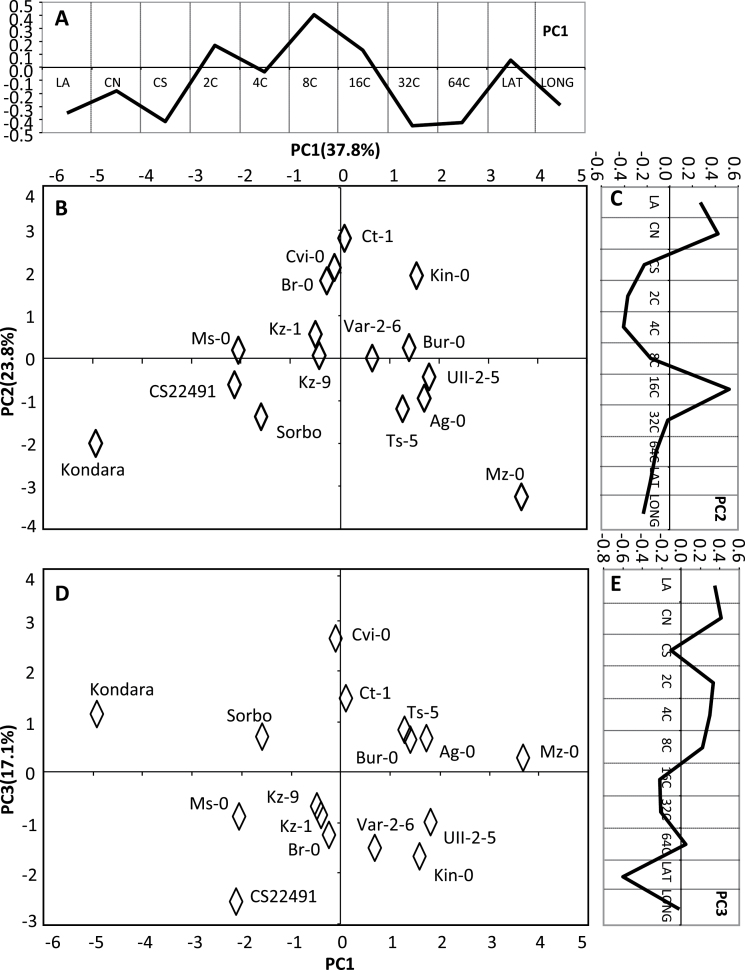
A phenotypic model for variation in leaf size and cellular parameters. The model defines cell number and high ploidy as significant factors for organ size variation. For example, Kondara and Ct-1 both reach similar leaf size but by increased high ploidy and cell number, respectively. In contrast, reduced ploidy acts as a limiting factor for leaf size in Mz-0. Three principal components (PC1–PC3) account for 78.7% of the variation in the Arabidopsis accessions. (A, C, E) Probability loadings of PC1, PC2, and PC3. (B) PCA sample distribution for PC1 versus PC2. (D) PCA sample distribution for PC1 versus PC3. Percentage of variation explained by each PC is given in parentheses. CN, cell number; CS, cell size; LA, leaf area; LAT, latitude; LONG, longitude (see also Supplementary Tables S1 and S2 available at JXB online).